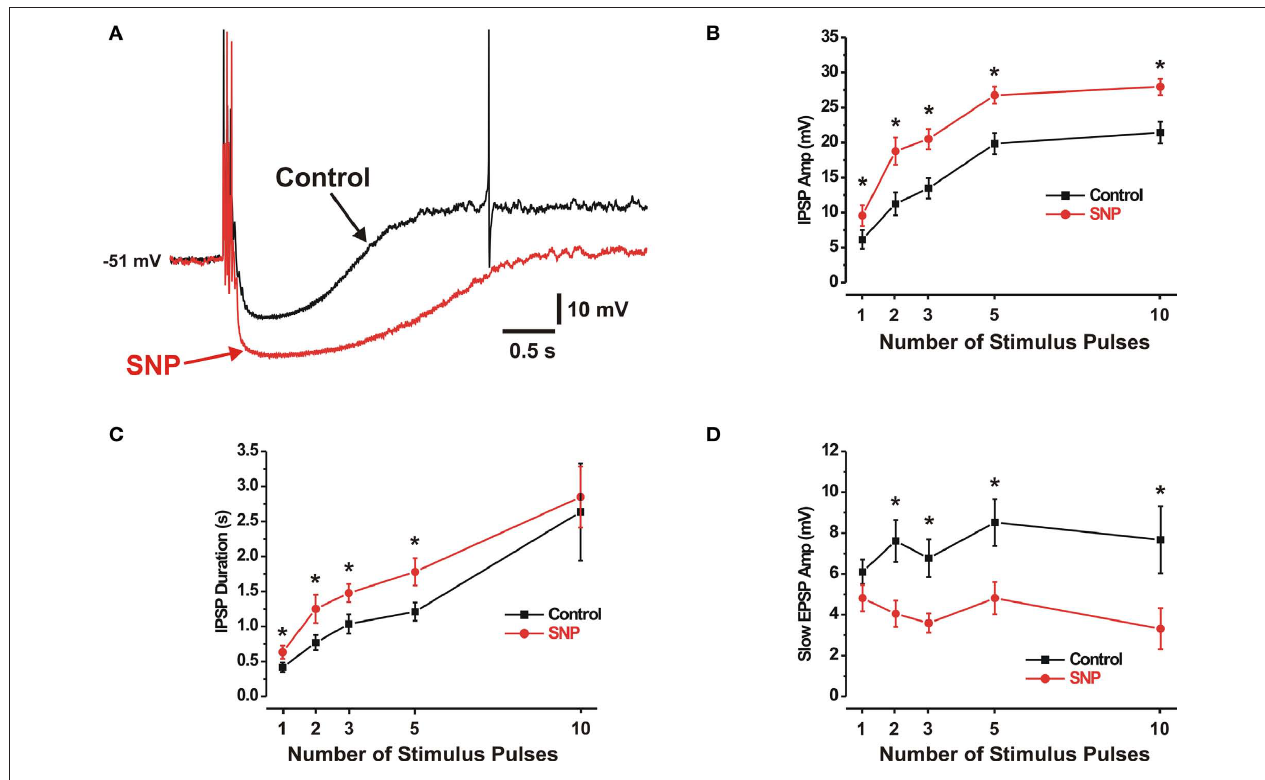
respectively of 1-, 2-, 3-, 5- and 10-pulse evoked IPSPs (control solid black line, SNP solid red line). (D) SNP reduced the amplitudes of 2-, 3-, 5- and 10-pulse slow EPSPs, but had no effect on single stimulus evoked SEPSPs. * P <